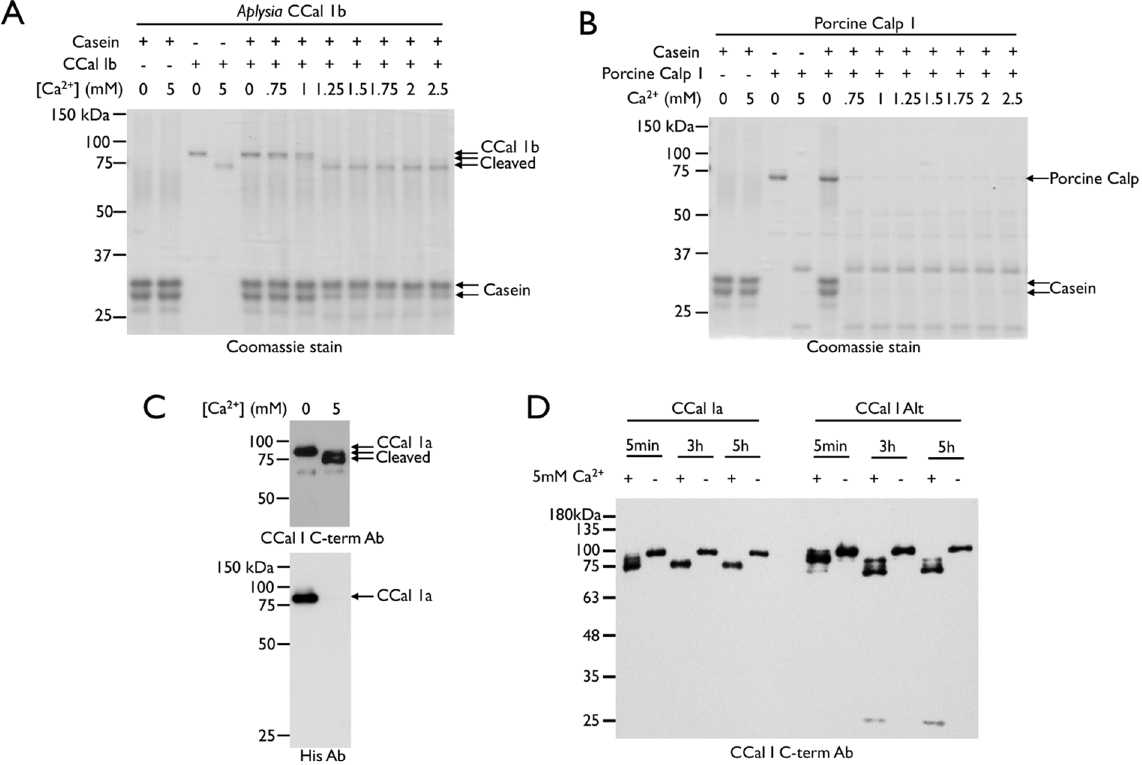
Fig 6. Autolysis of Aplysia AplCCal1 produces a stable cleavage product. Coomassie-stainedgel representing (A) Aplysia AplCCal1b(80ng/ul)and (B) Porcine classical CAPN-1 (80ng/ul)incubatedwith casein (225ng/ul)for 30 min at variousCa 2+ concentrations. Twenty-eight microlitersof the reactionwas loaded. (C) Aplysia AplCCal1a(290ng/ul)was incubatedwith or without Ca 2+ for 30 min. Thirty-one microlitersof the reactionwas subjectedto immunoblot with an antibody againstthe N-terminal His-tag, stripped and reprobedwith an AplCCal1C-terminal antibody.(D) AplCCal1aor AplCCal1alt (50ng/ul)was incubatedin the presence or absenceof Ca 2+ . At the indicatedtimepoints, 25ul of each reaction was removedand inactivatedby addition of 5X Laemmlisample buffer. Samples were subjectedto immunoblot with an antibody againstthe AplCCal1C-terminus.